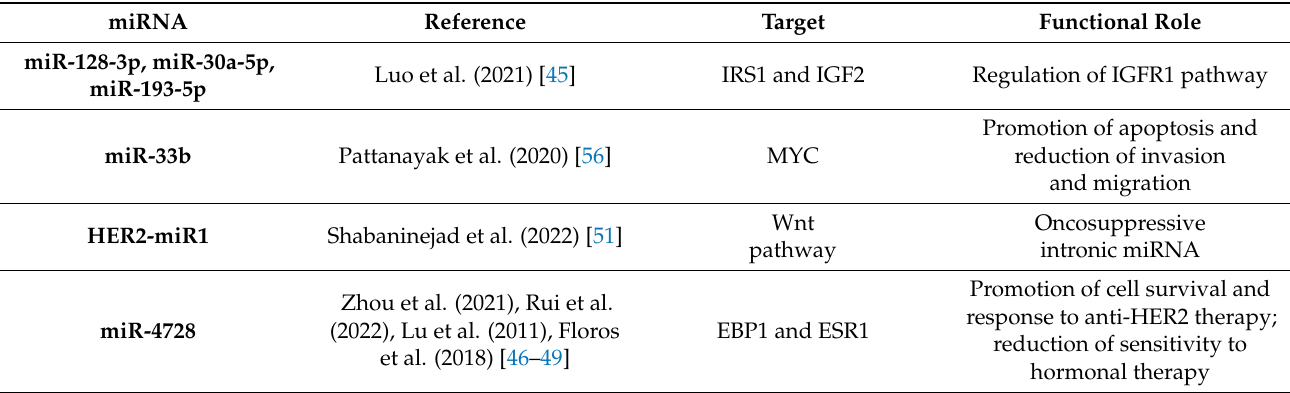
Figure 1. Graphical summary of HER2-related pathway regulation by miRNAs involved in tumor formation, progression, metastasis, and therapy resistance. Aberrantly activated signaling pathways can lead to differently expressed miRNAs, causing the deregulation of their target mRNAs. For instance, miR-221/222 are activated downstream of HER2 and are able to directly target ER. HER2-activated FOXO3 also regulates the IGFR1 pathway by inducing the expression of miR-193-5p, miR-30-5p, and miR-128-3p. Vice versa, miRNAs can also regulate members of the HER family themselves, such as HER3, which is directly targeted by miR-205. This figure was created with BioRender.com. Table 1. Functional role of miRNAs in HER2+ breast cancer.